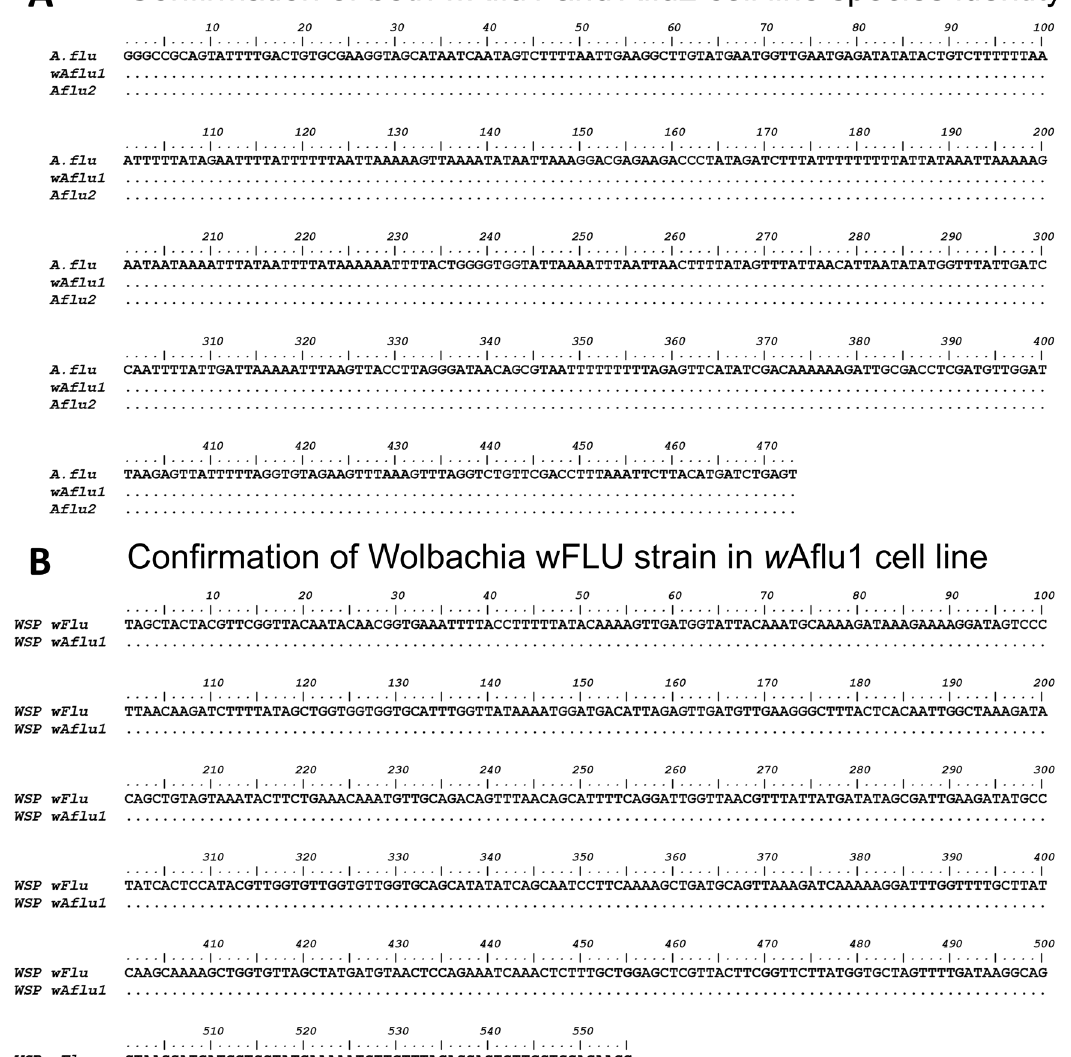
Figure 1. Sequence identification of mosquito cell lines and the Wolbachia strain. Sequence alignment of the 16S rRNA fragment obtained from the Aedes fluviatilis mosquito (MW574133) with 16S rRNA fragment obtained from the w Aflu1 and Aflu2 cell lines, showing identical sequences ( A ). Sequence alignment of WSP gene fragment obtained from Wolbachia strain w Flu (GQ917108) is identical to the sequence amplified from w Aflu1 cell line ( B ). Dots represent identical